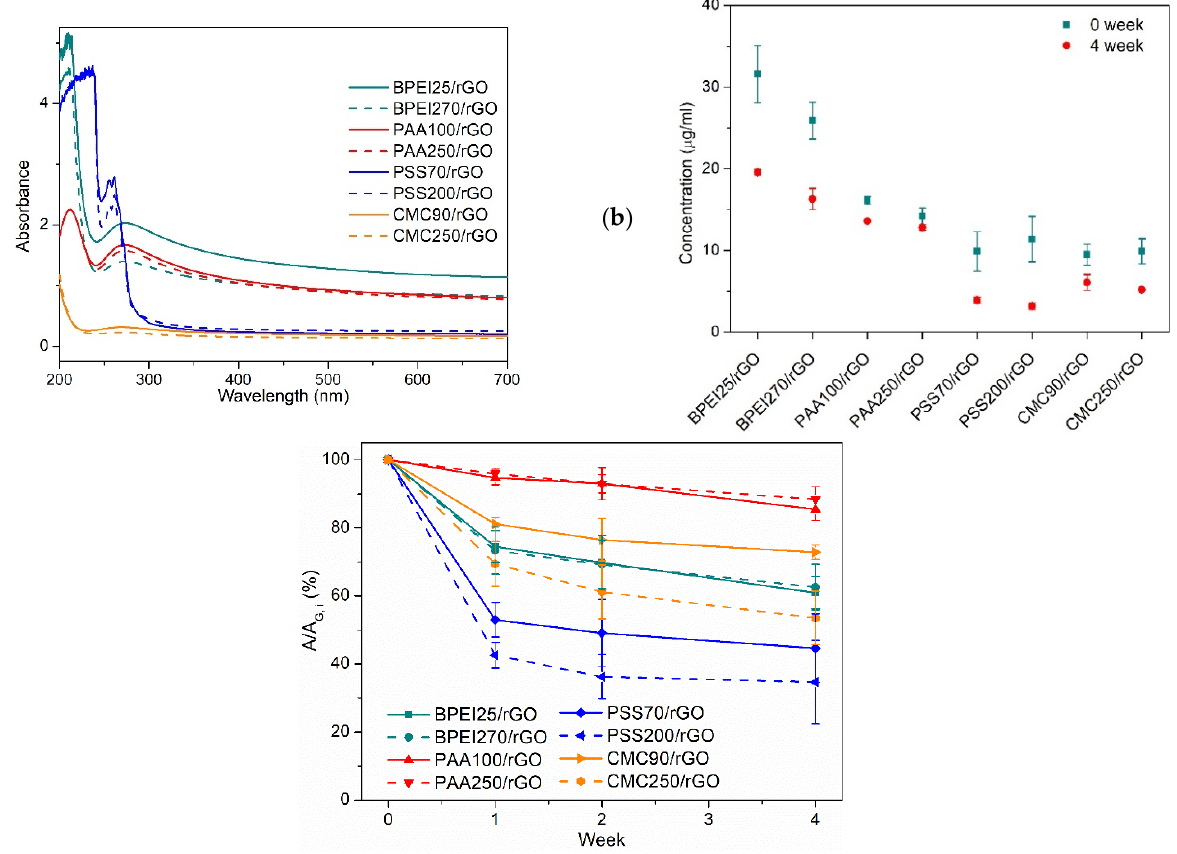
Figure 3. UV-vis spectra of PE/rGO dispersions ( a ); concentration of rGO in PE/rGO dispersions ( b ); the amount of remaining rGO in dispersions after 0 to 4 weeks, expressed as the percentage of the original absorption (original concentration), A/A G,i ( c ).